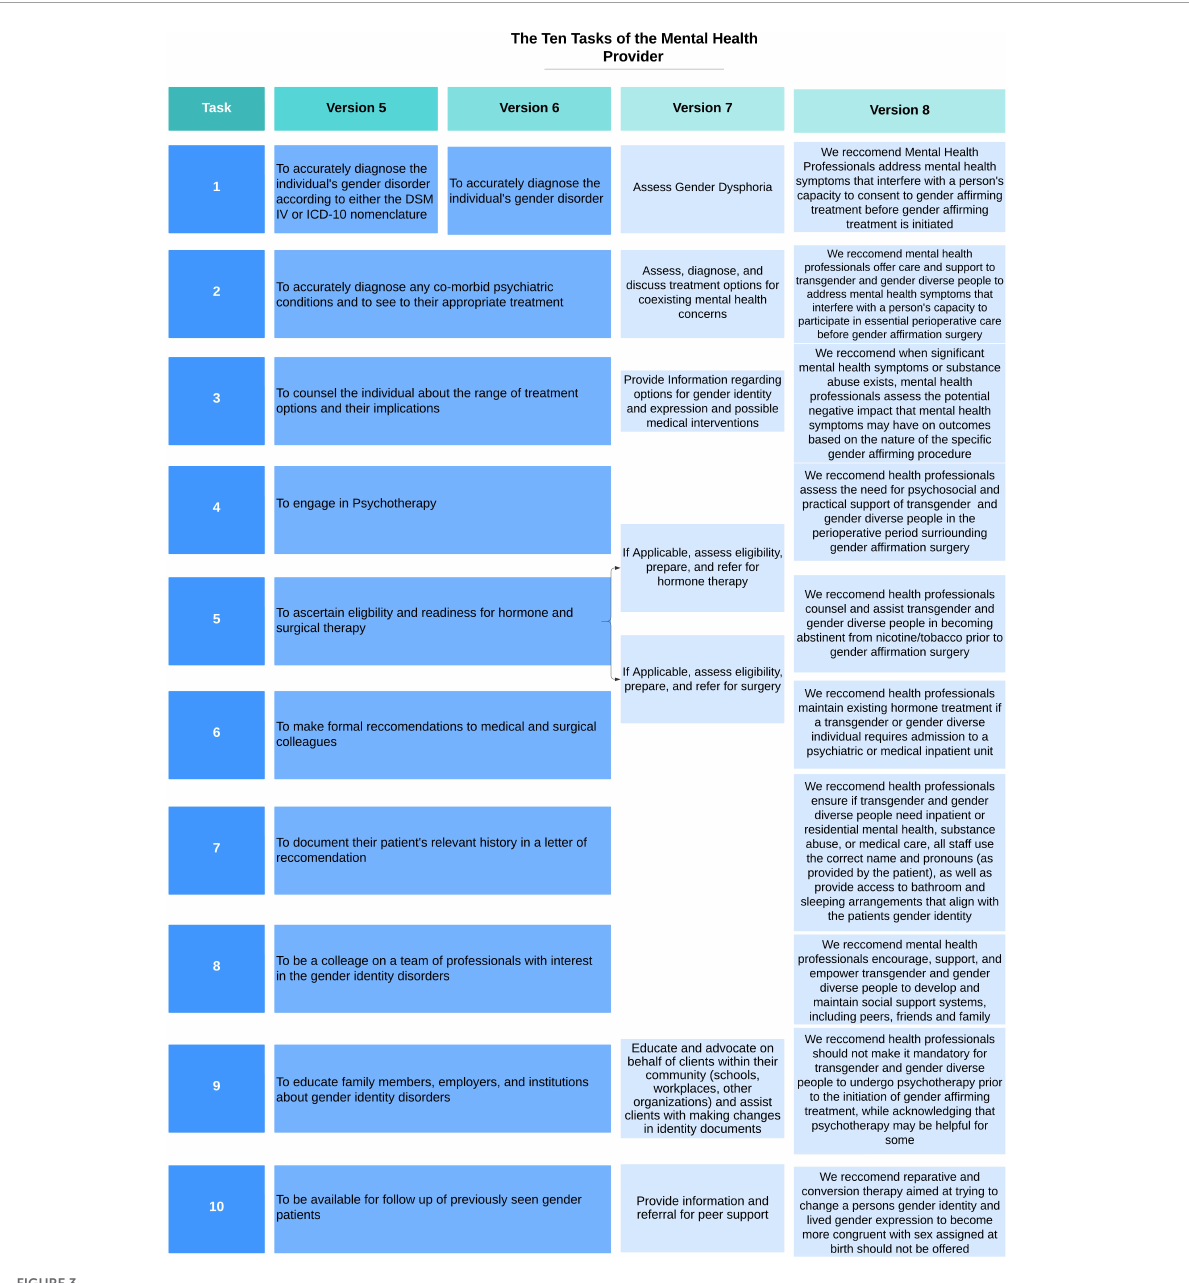
FIGURE3 Changes to the ten tasks of the mental health provider within the World Professional Association for Transgender Health (WPATH) standards of care over